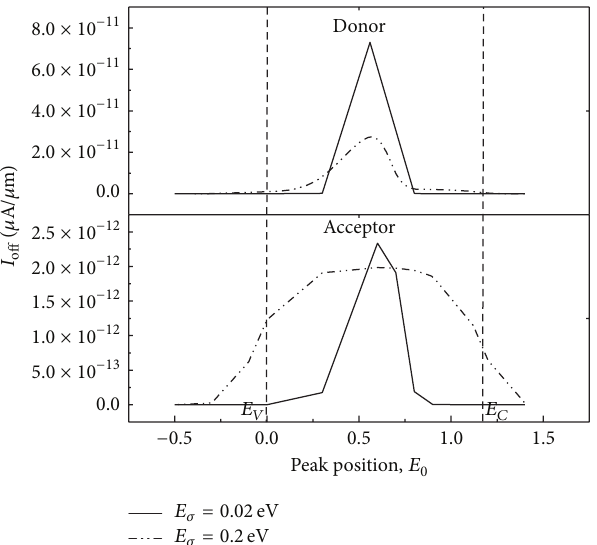
Figure 5: The extracted off-state current 𝐼 ITs and acceptor-type ITs; 𝑉